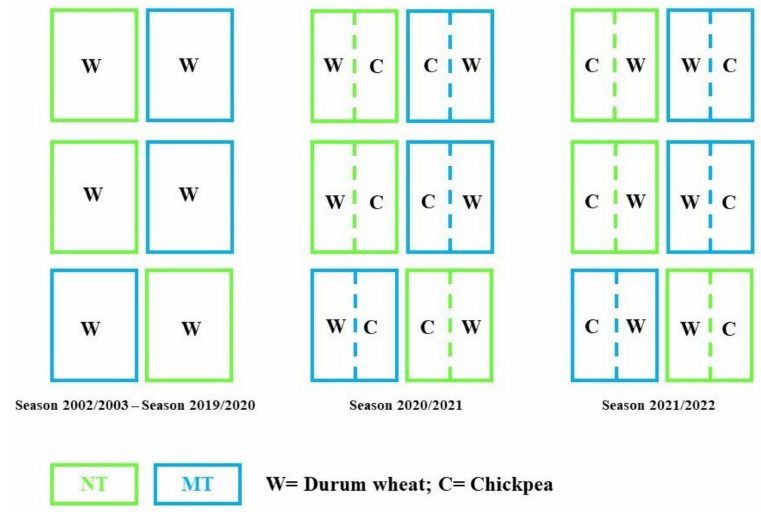
Figure 2. Experimental design of long-term field experiment located in the farm of CREA-AA,